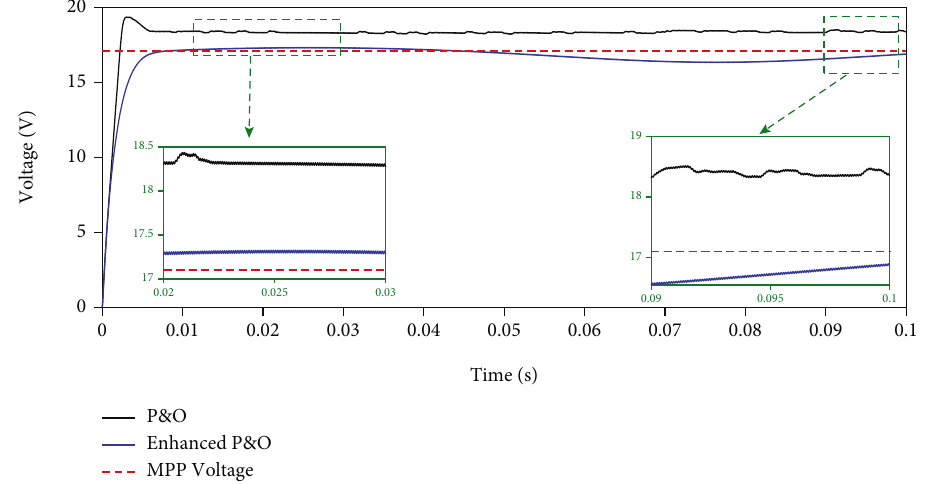
Figure 16: Tracking of MPP voltage with P&O and enhanced P&O MPPT method under Test 2.